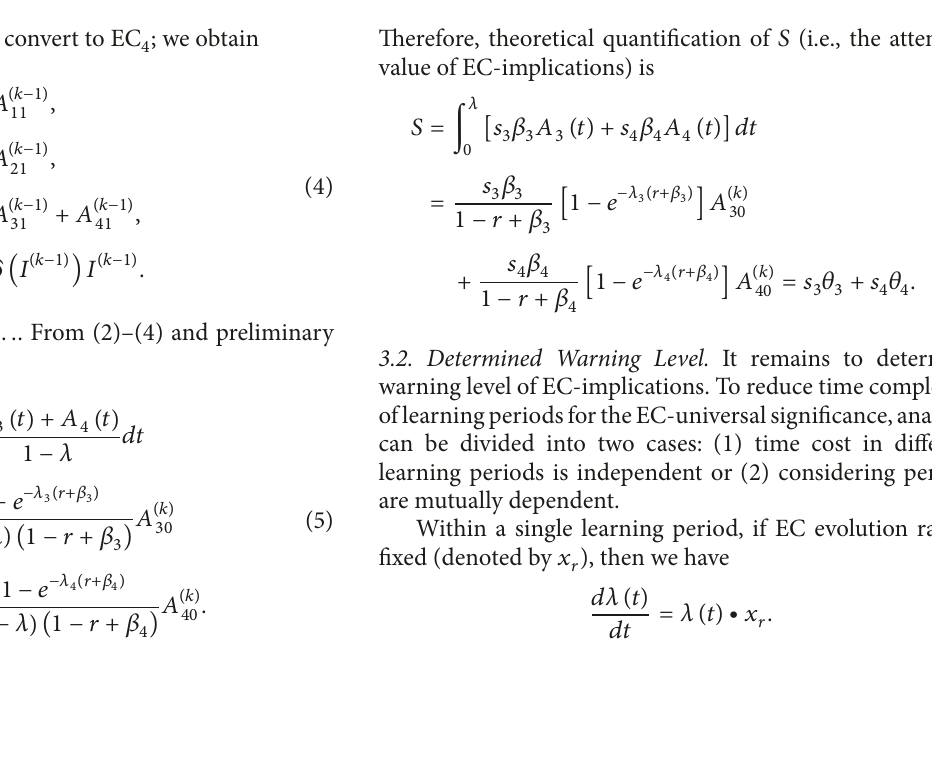
Figure 3: Brain-inspired evolution of attention value and warning level of environment changes, the attention values of EC-implications and behaviors/accidents are represented by the circles size and text color, respectively, while the warning level of EC-implications is represented by the arrows